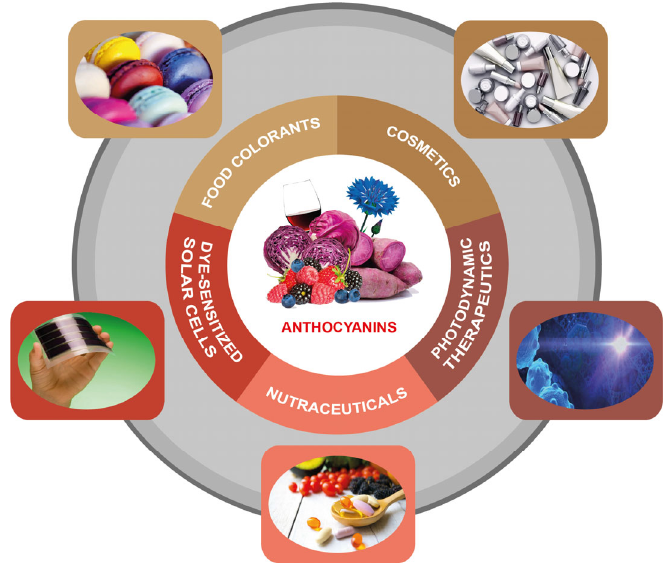
Figure 4. Biomedical and technological applications of anthocyanins.